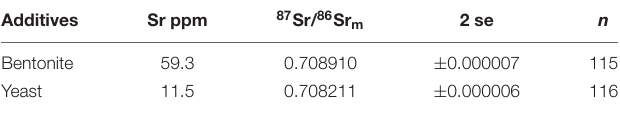
TABLE 4 | Isotopic composition and Sr content of